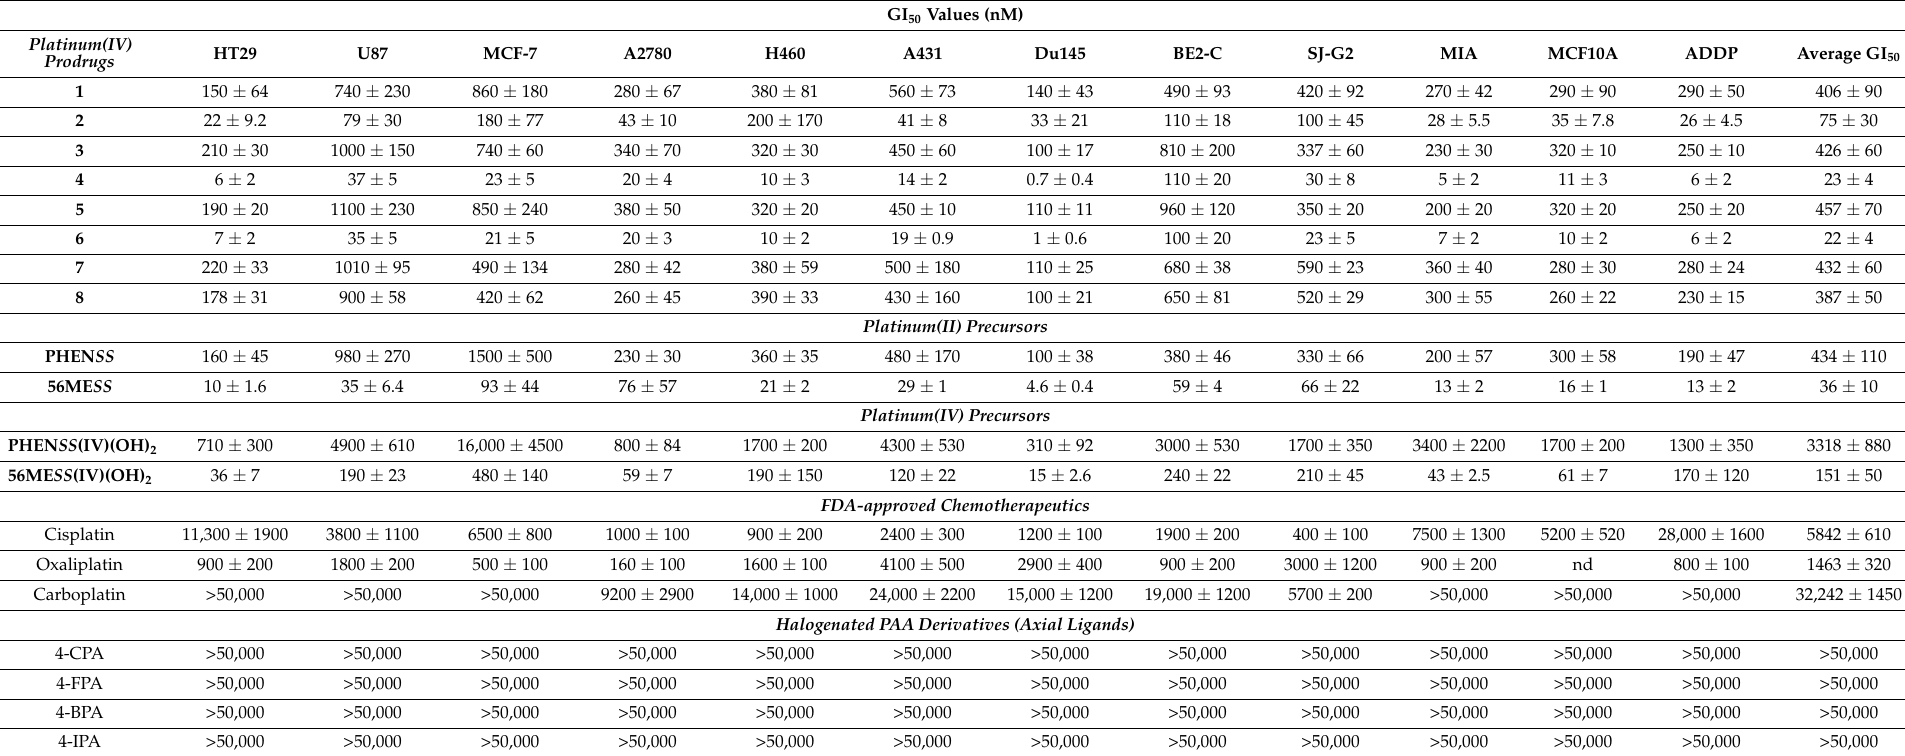
Table 7. A summary of the GI 50 values (nM) of 1 – 8 , 4-CPA, 4-FPA, 4-BPA, and 4-IPA in multiple cell lines. The data presented for cisplatin, oxaliplatin, carboplatin, and precursor platinum(II) and platinum(IV) precursors were obtained from a previous study [21]. nd = not determined. GI 50 Values